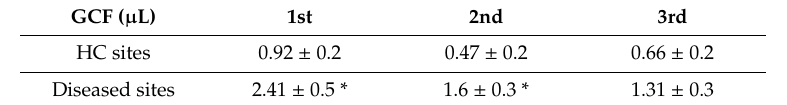
Table 5. Changes in GCF volume at HC and diseased sites during the periodontal